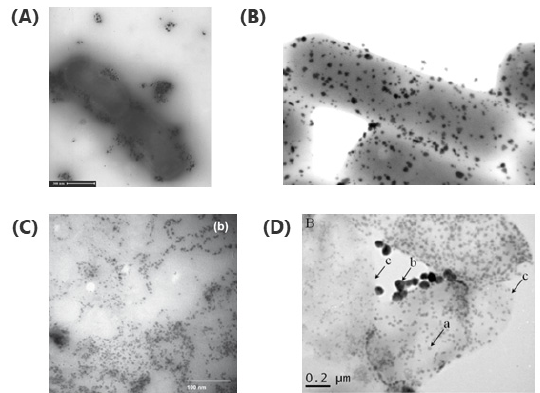
Figure 1. TEM image of microbial synthesized nanoparticles (NPs). ( A ) Ag NPs [28], ( B ) Au NPs [29], ( C ) CdS NPs [18], ( D ) CdSe NPs [30]. Reproduced with permission from Korbekandi, H. et al., Journal of Chemical Technology & Biotechnology; published by Wiley, 2012; Prasad, K. and Jha, A.K., Journal of Colloid And Interface Science; published by ELSEVIER, 2010; Ayano, H. et al., Journal of Bioscience and Bioengineering; published by ELSEVIER, 2015.